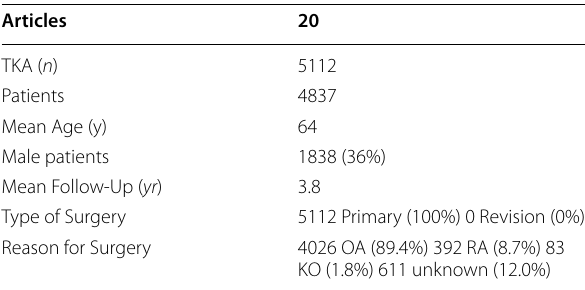
Table 2 Clinical characteristics for Stryker Triathlon cementless TKA